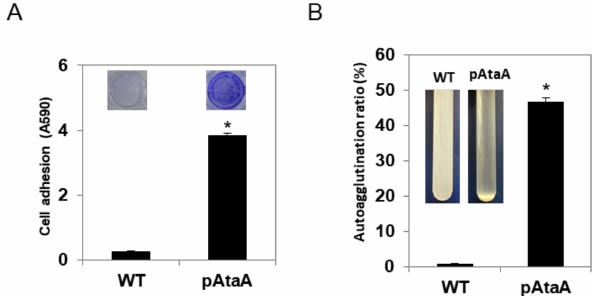
Figure 2. Adherence and auto-agglutination assay of Enterobacter aerogenes- expressing ataA . ( A ) A cell suspension was placed on the polystyrene plate, and the cells adhering to the bottom of a 48-well were stained with Crystal Violet (photographs, inset). Adherent cells were quantified by measuring the Crystal Violet absorbance at 590 nm. ( B ) The sediment of the transformant at the bottom of the test tube was observed after settling for 3 h (photographs, inset), and the auto-agglutination ratio was calculated from the OD 600 decrease in the upper segment of the cell suspension. Data are the mean ± SD of three independent measurements. Significant differences between the data (student t -test, p < 0.01) are marked with asterisk